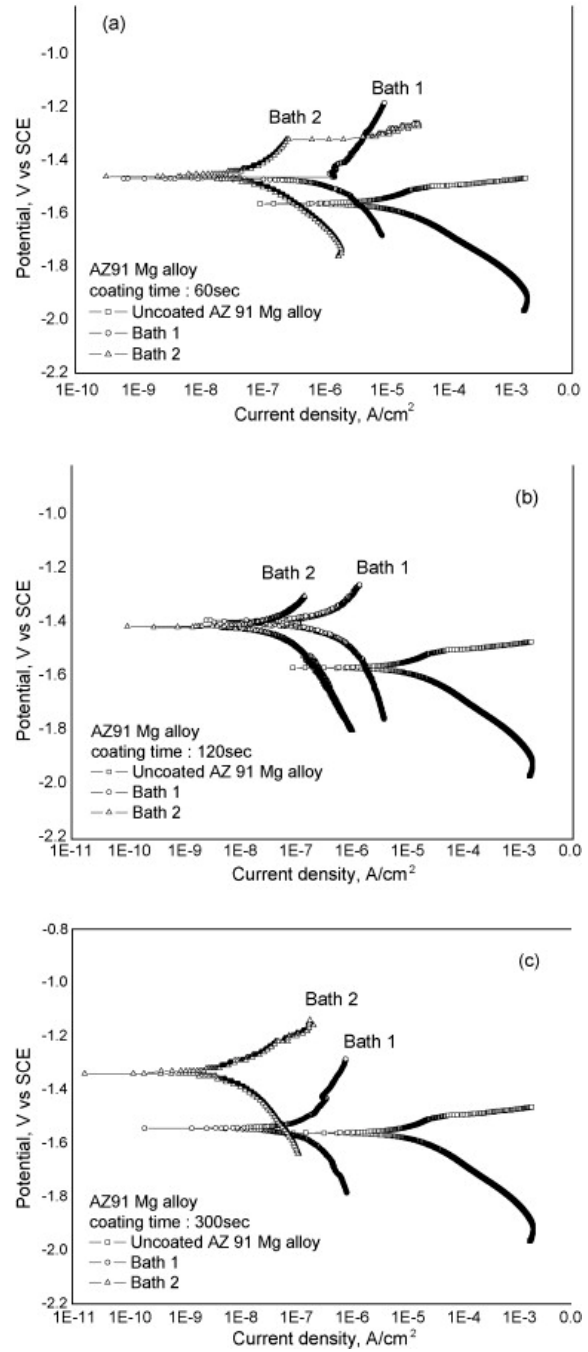
Figure 14. Potentiodynamic polarization curves of coatings formed in electrolyte without (Bath 1) and with KMnO 4 (Bath 2); ( a ) samples coated for 60 s; ( b ) samples coated for 120 s; ( c ) samples coated for 300 s [175]. Reprinted from [175] with permission from Elsevier.